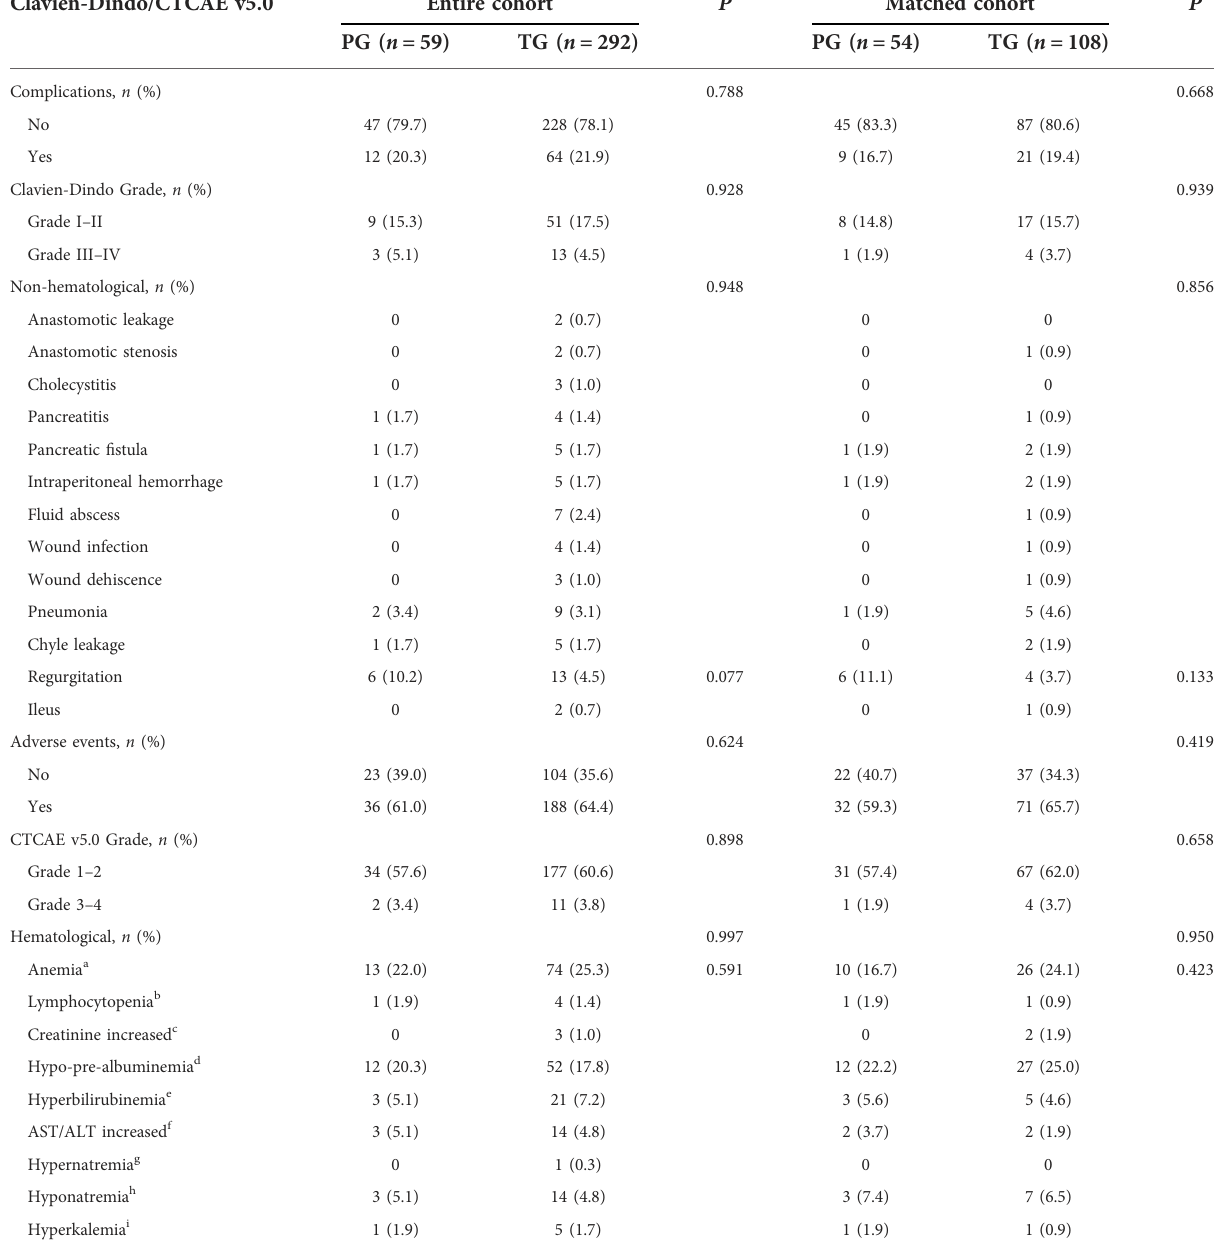
TABLE 4 Postoperative morbidity and adverse events within 30 postoperative days. Clavien-Dindo/CTCAE